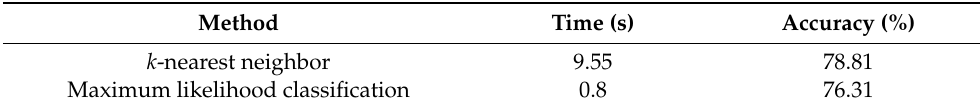
Table 12. Comparison of training time and model’s accuracy generated using the k -NN and MLC methods.